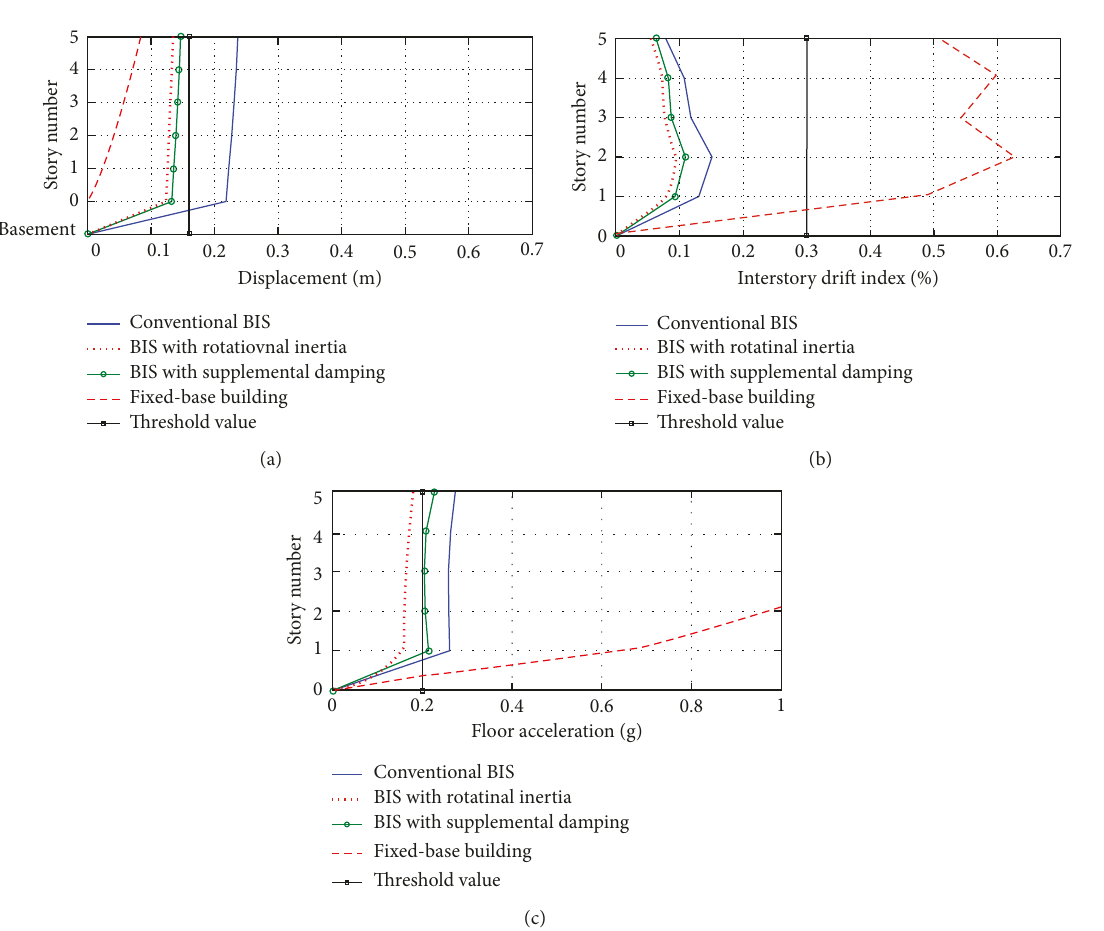
Figure 17: Monte Carlo method with 100 artificial samples: average maximum distribution of horizontal displacements (a), interstory drift index (b), and floor acceleration (c) compared to threshold values as per